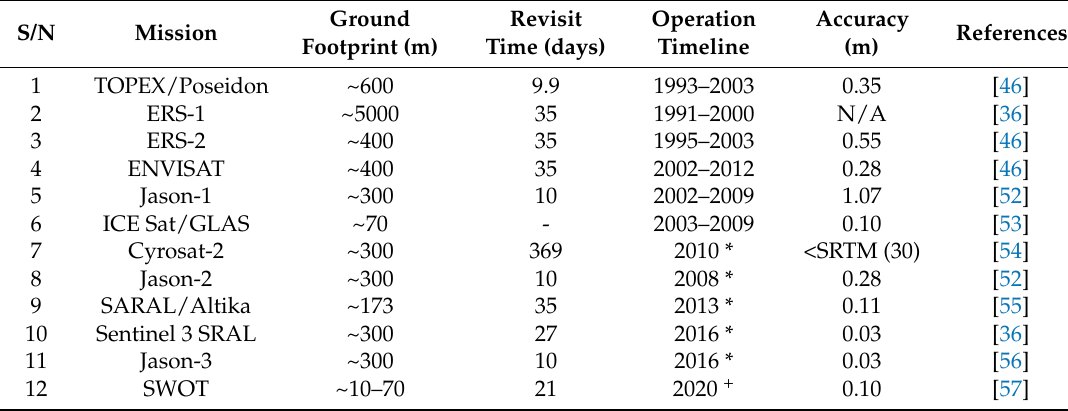
Table 2. Altimetry characteristics adapted from